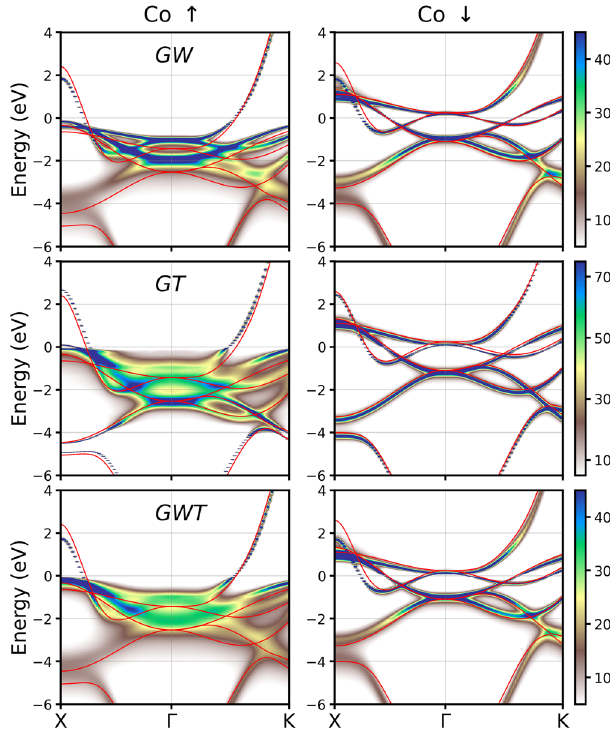
Fig. 7 Renormalized band structures of fcc Co. Spin-dependent band structures of renormalized with GW , GT , and GWT self-energies along X − Γ − K.